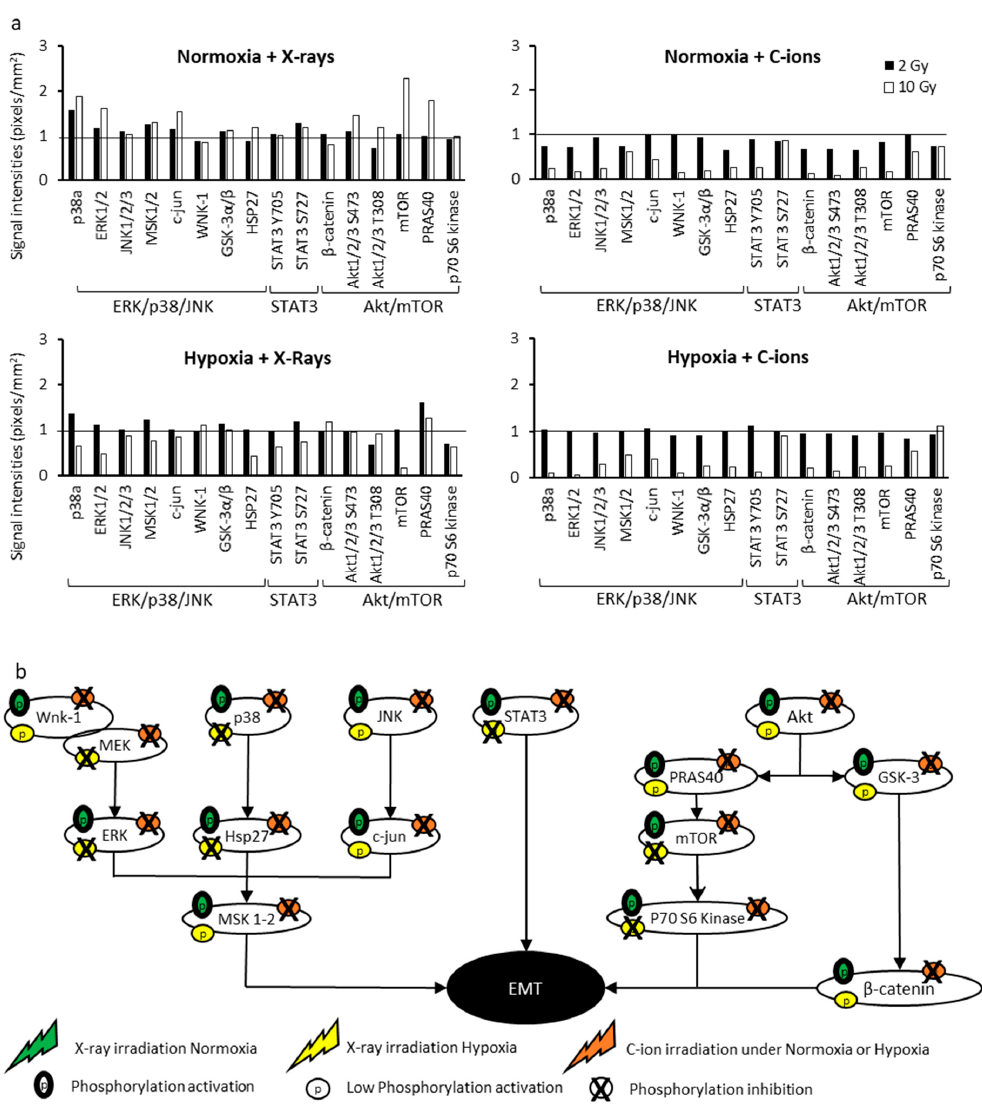
Figure 5. Signaling pathways involved in the migration/invasion processes. ( a ) The phosphorylation levels of the proteins involved in the MEK/p38/JNK, STAT3 and Akt/mTOR pathways were determined for SQ20B-CSCs in response to 2 or 10 Gy X-rays and C-ion irradiation ± chronic hypoxia, and normalized to basal conditions using the Proteome Profiler Human Phospho-Kinase Array Kit. A signal > 1 corresponded to an activation of phosphorylation, whereas a signal < 1 was associated with an inactivation of the kinases ( n ≥ 2 in duplicate). ( b ) Schematic representation of the MEK/p38/JNK, STAT3 and Akt/mTOR pathways involved in migration/invasion under normoxia and hypoxia as a function of the type of irradiation.